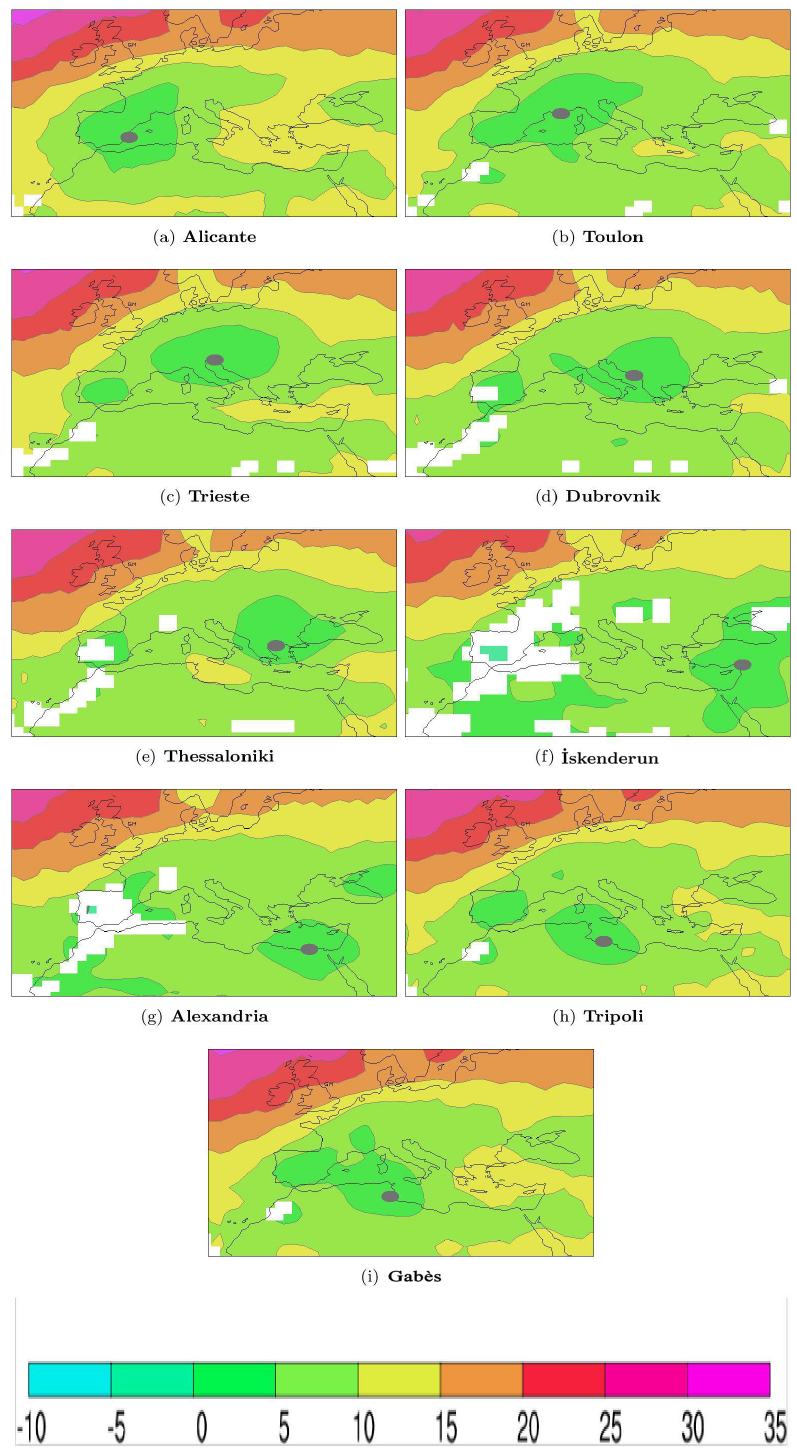
Figure 10. Difference between MSLP (hPa) at the coastal station and cyclone pressure minimum as function of cyclone position. Each panel considers a different coastal station: Alicante (a) , Toulon (b) , Trieste (c) , Dubrovnik (d) , Thessaloniki (e) , ˙ Iskenderun (f) , Alexandria (g) , Tripoli (h) , Gabès (i) . Only values reaching the 90% significance level are